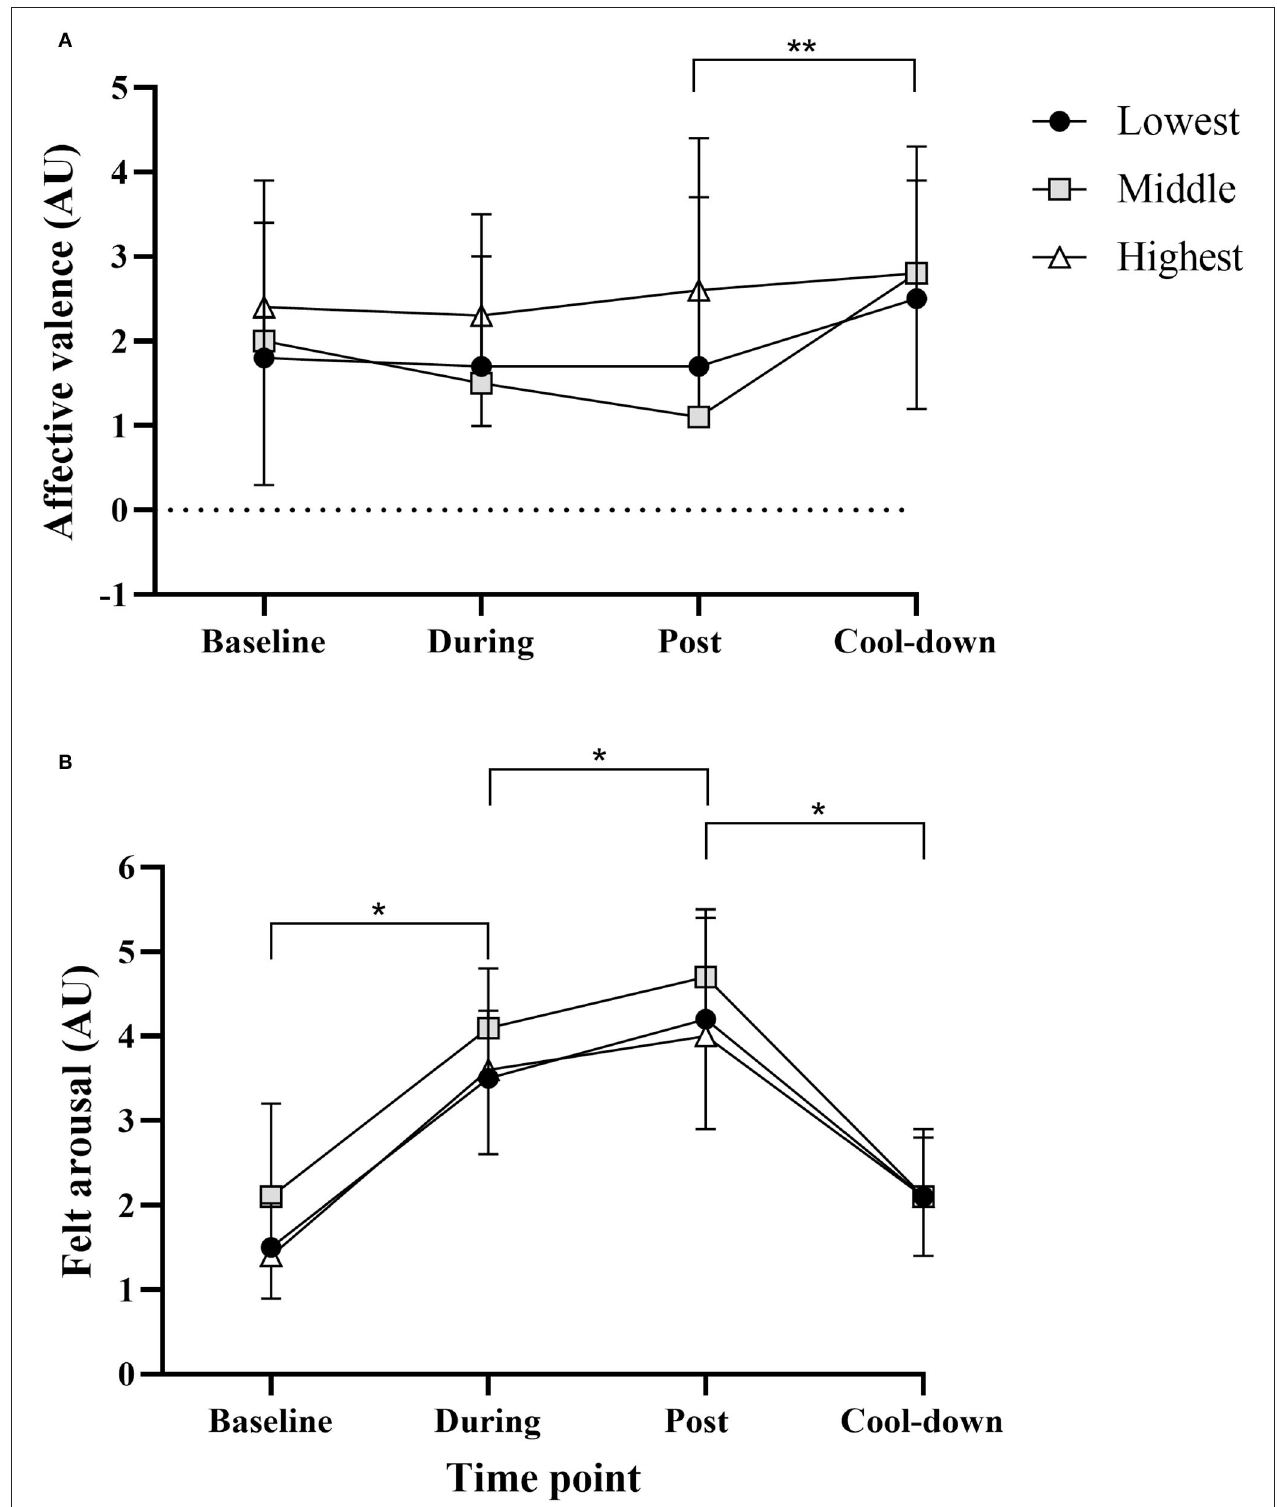
FIGURE 3 | Affective valence (A) and felt arousal (B) data for all groups at each time point. Data are mean (SD). *Significant pairwise comparison ( p < 0.001); **Significant main effect of time ( p = 0.04).